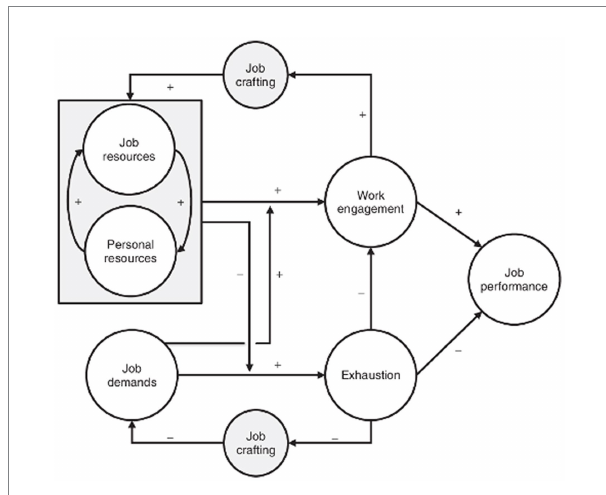
FIGURE 1 JD-R theory. Adapted from Bakker and Demerouti